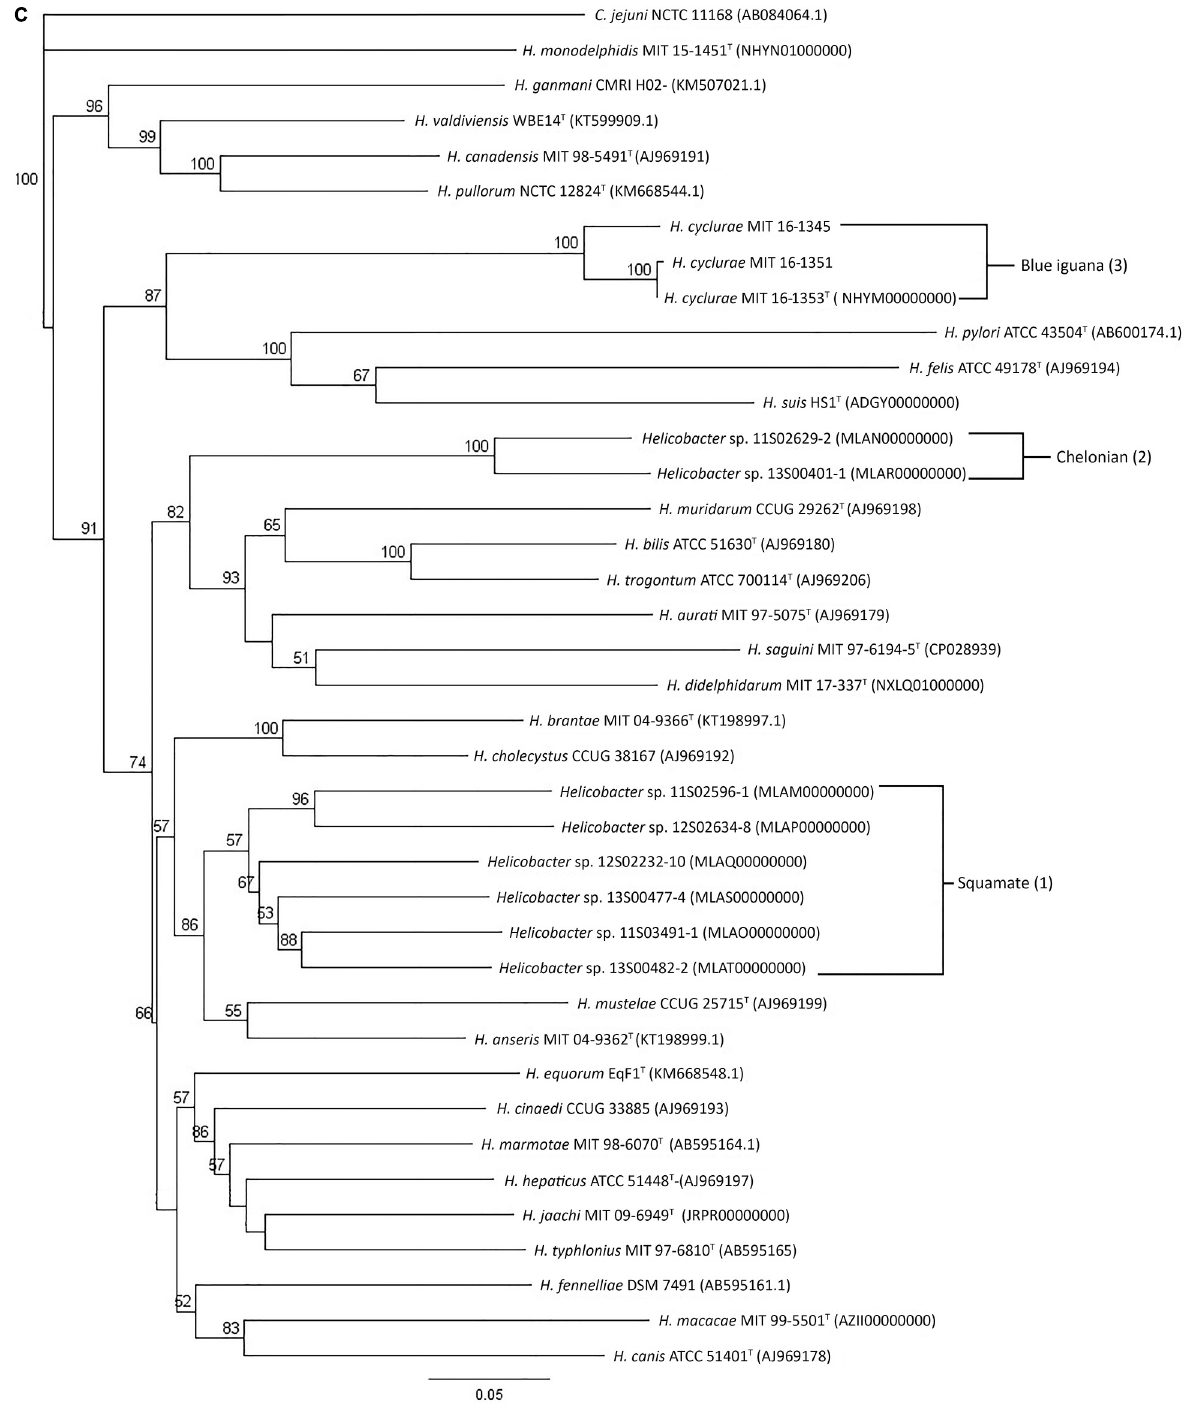
Frontiers in Ecology and Evolution |